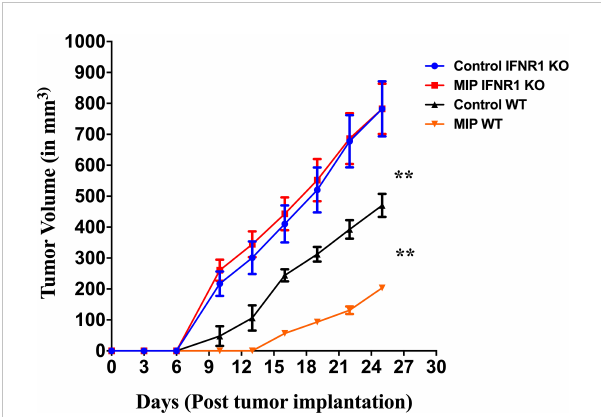
FIGURE 5 Tumor growth kinetics in wild type and IFNR1 -/- mice: 50,000 B16F10 cells were injected in the right fl ank of wild type (BL/6) and IFNR1 -/- mice. MIP was administered peritumorally on day 3, 10, 17 post tumor implantation. Tumor growth was measured every 3 days. Control tumor bearing mice were injected PBS instead of MIP. Tumor volume was calculated using the formula (0.5 x large diameter x small diameter 2 ). Data are mean ± SEM values obtained from 8 mice/group. Statistical analysis was performed using two-way ANOVA. (**:p<0.01) Three independent experiments have been